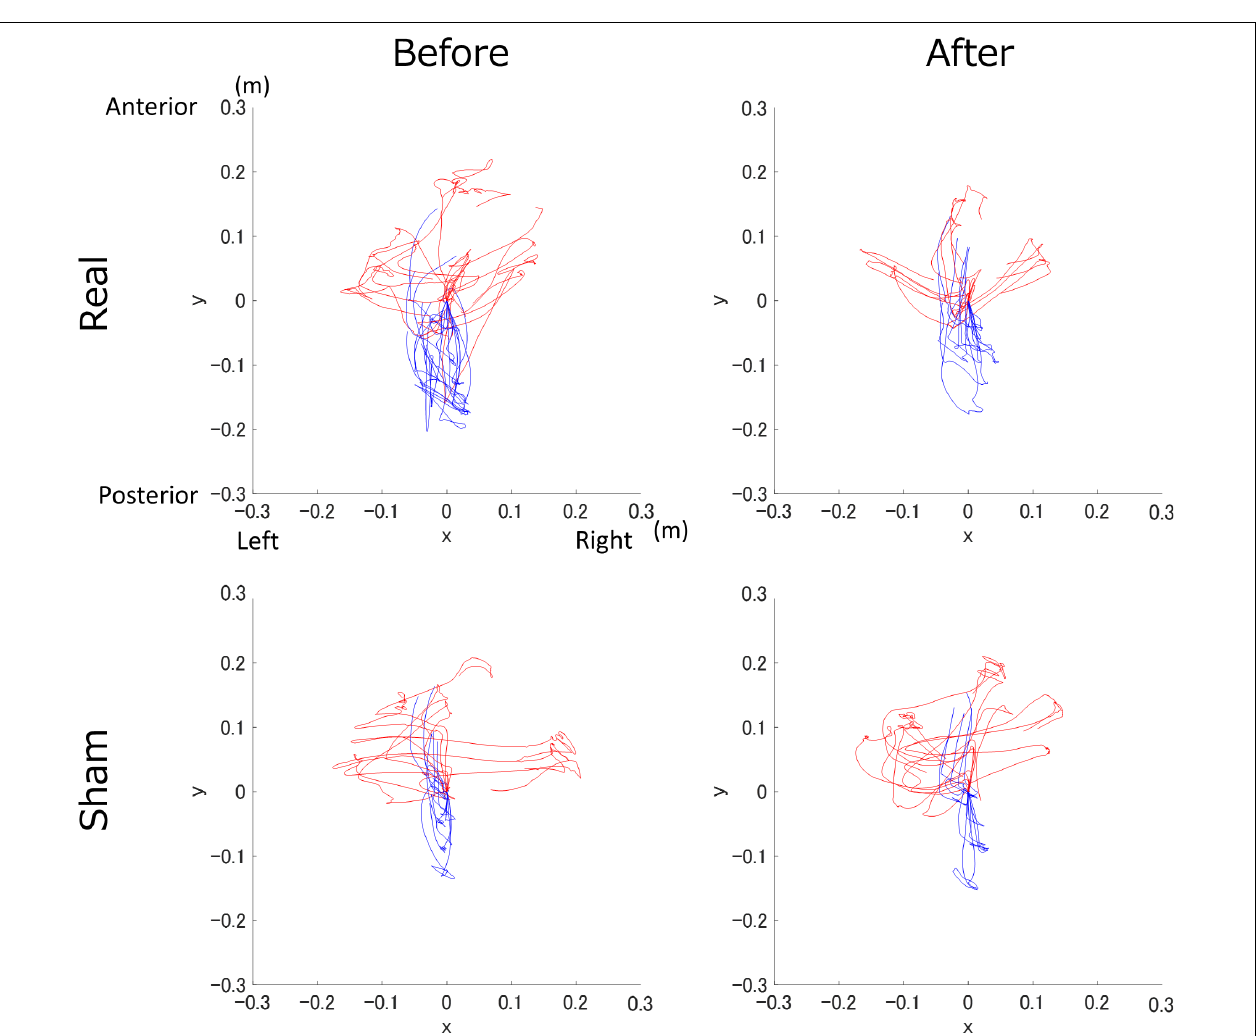
FIGURE 3 | Trajectory example of the real and sham groups before and after transcranial direct current electrical stimulation (tDCS). The top row shows the real tDCS group, the bottom row shows the sham tDCS group, and the columns from left to right are before and after tDCS. The S1 and S2 trajectories are shown in blue and red,